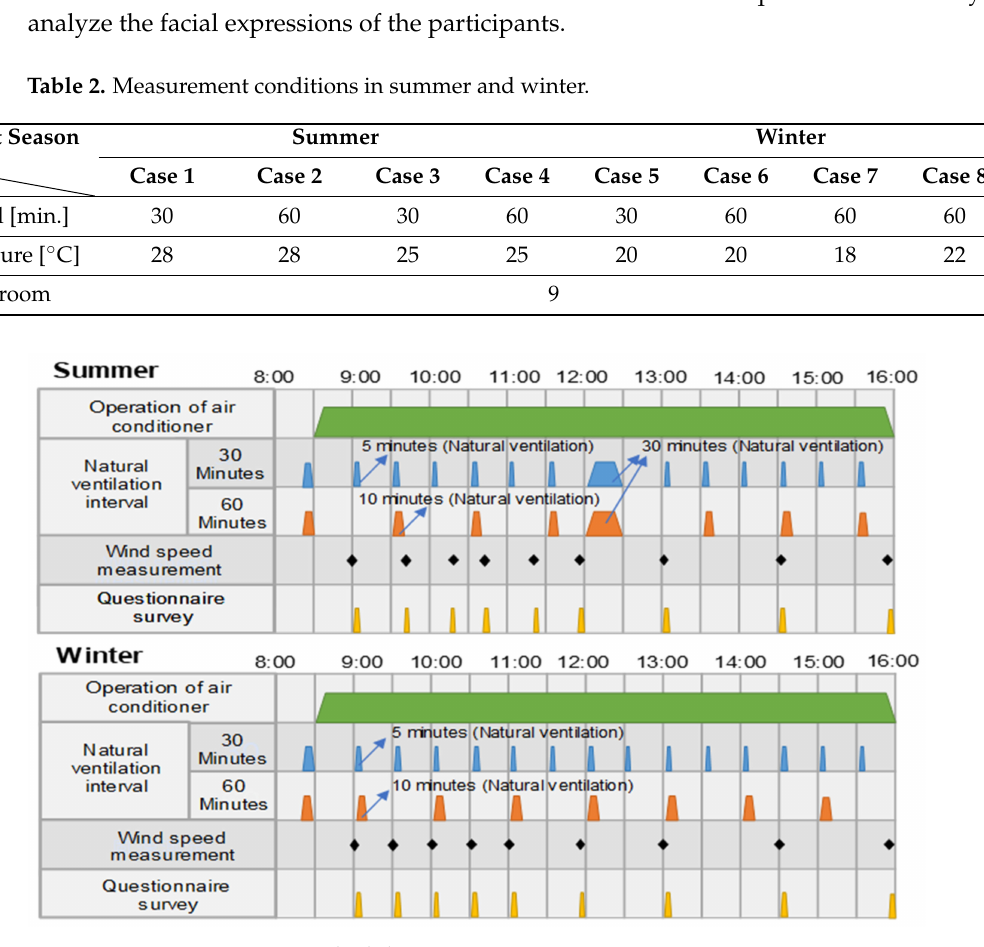
Figure 3. Measurement time